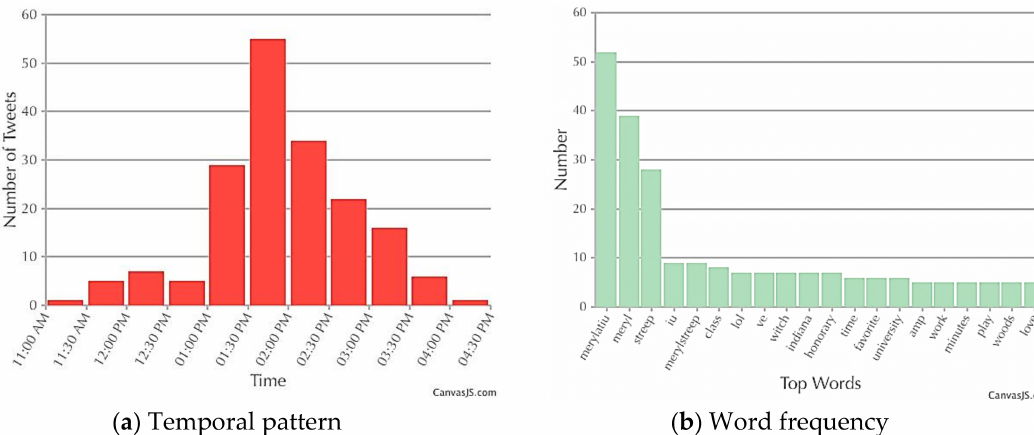
Figure 11. Temporal pattern and word frequency of Meryl Streep’s visit to Indiana University on 16 April 2014: ( a ) Temporal pattern; and ( b ) Word